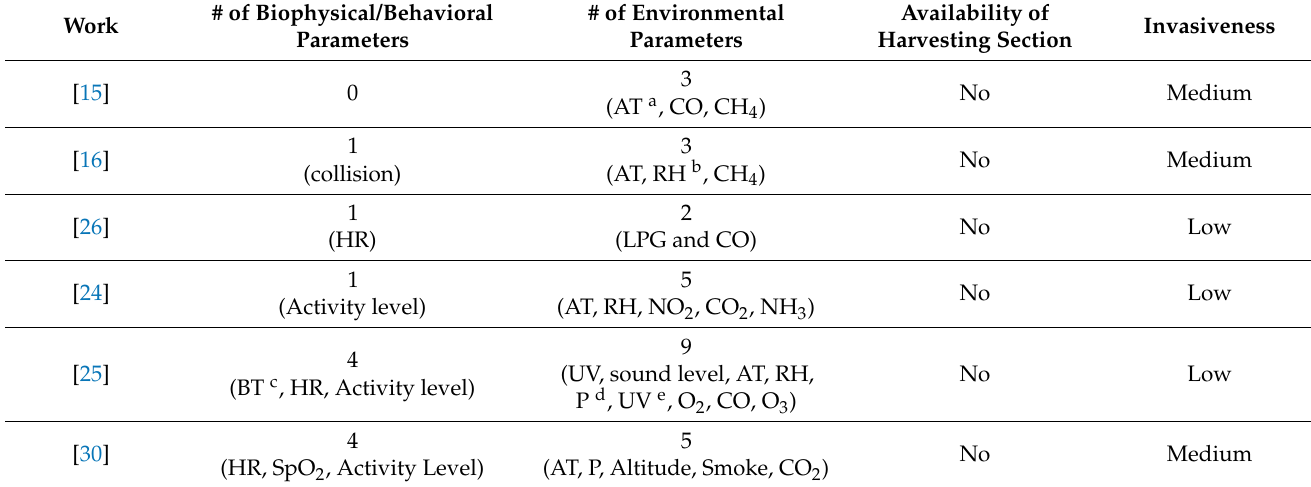
Table 6. Comparison of our smart garment with other similar devices reported in the scientific literature considering the number of acquired environmental and biophysical parameters, availability of the harvesting section, and